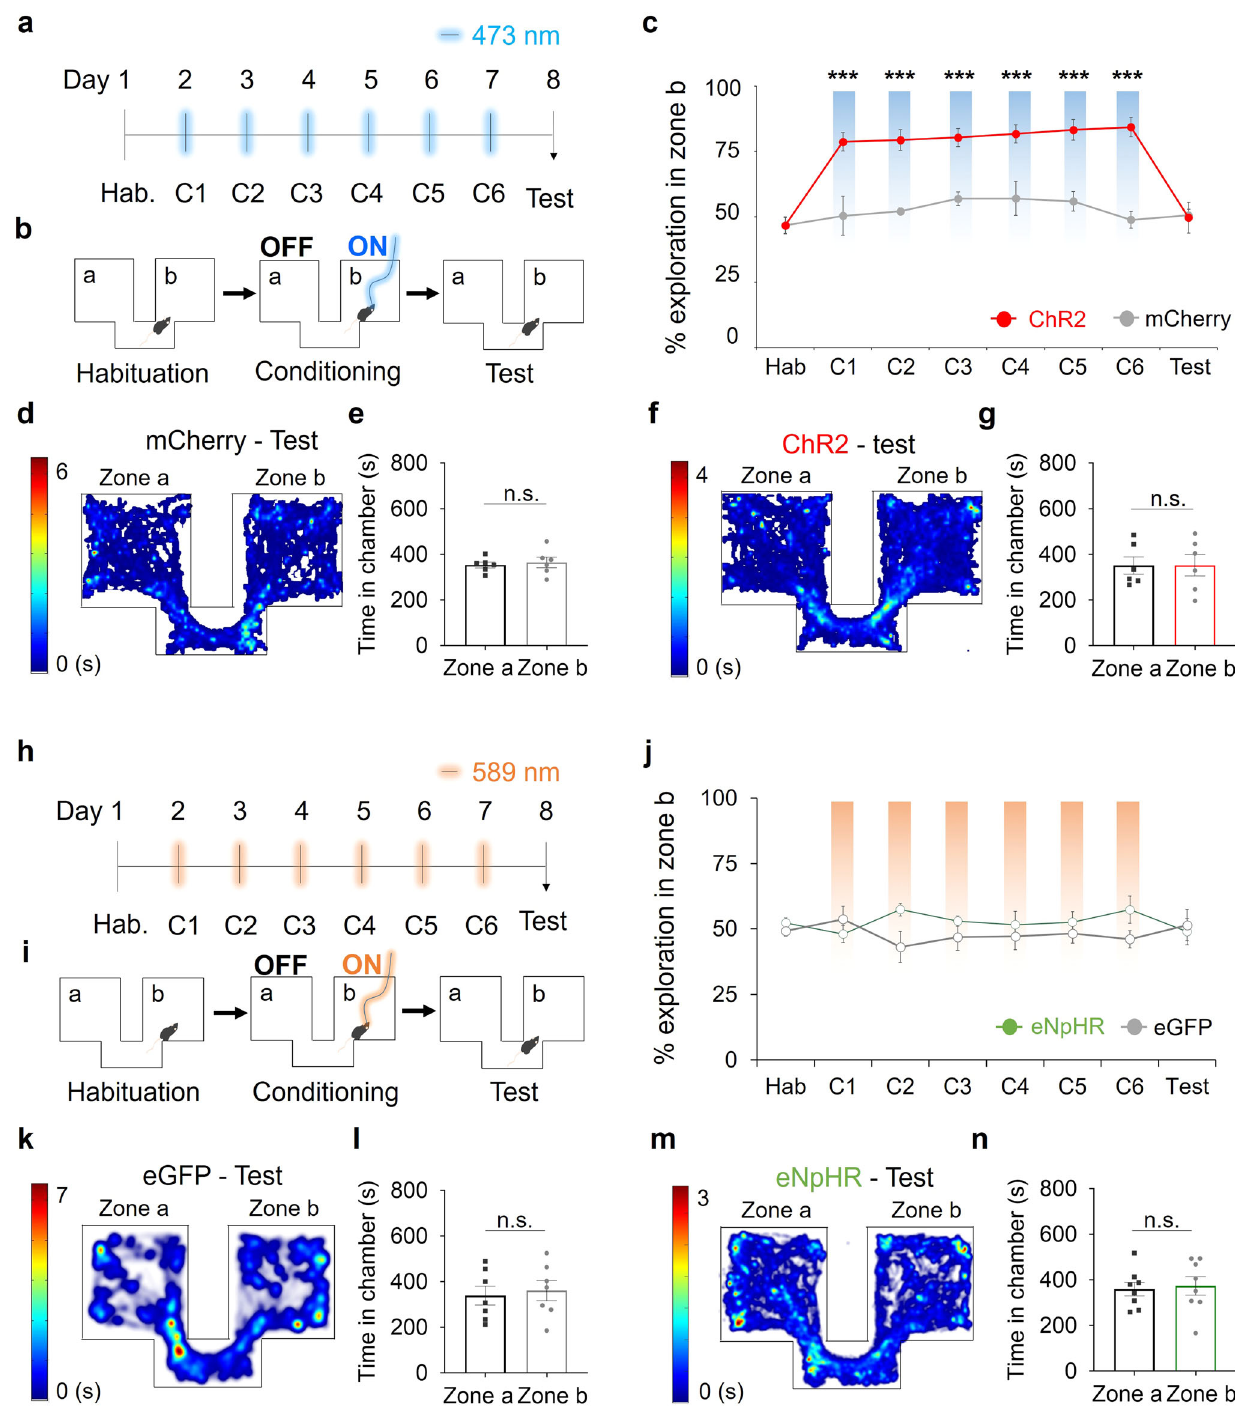
Fig. 4 MPA-vPAG circuit stimulation increases place exploration behavior. a The timeline for the CPP test. b Custom chamber design and light- stimulation protocol. c Exploration of zone b (%) by the ChR2 group (red, n = 6) and the mCherry group (gray, n = 6; two-way RM ANOVA test, Holm- Sidak post-hoc analysis). d A representative heat map of mouse center points locations during the CPP test. e Time in zone a vs. zone b for the mCherry group during the CPP test ( n = 6; paired two-tailed t -test). f A representative heat map of mouse center points locations during the CPP test. g Time in the zone a vs. zone b for the ChR2 group during the CPP test ( n = 6; paired two-tailed t -test). h The timeline for the CPP test. i Custom chamber design and light stimulation protocol. j Exploration of zone b (%) by the eNpHR group (green, n = 8) and eGFP group (gray, n = 7; two-way RM ANOVA test, Holm- Sidak post-hoc analysis). k A representative heat map of mouse center points locations during the CPP test. l Time in zone a vs. zone b for the eGFP group during the CPP test ( n = 7; paired two-tailed t -test). m A representative heat map of mouse center points locations during the CPP test. n Time in zone a vs. zone b for the eNpHR group during the CPP test ( n = 8; paired two-tailed t -test). *** p < 0.001. n.s., not signi fi cant as p > 0.05. All error bars represent s.e.m. Further information on statistical analyses is given in the supplementary data